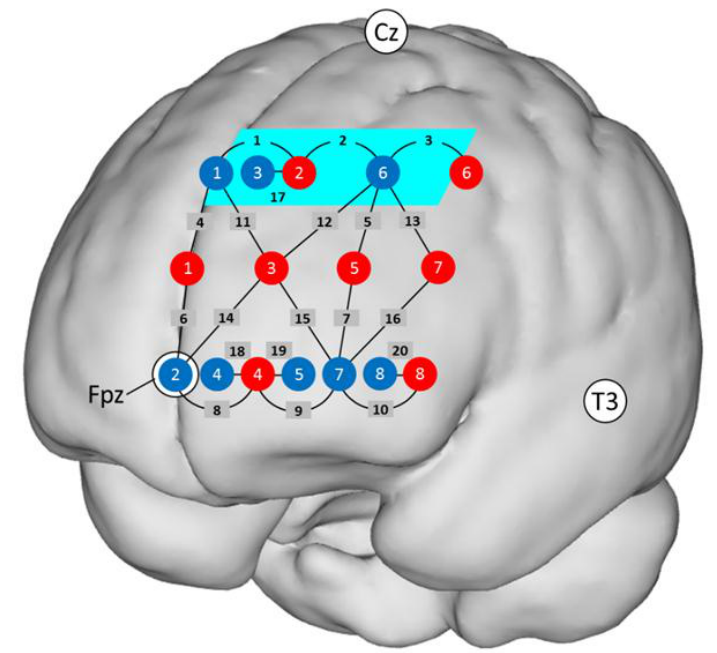
Figure 2. Localization of the 20 channels projected on a standard brain. There were eight detectors (blue dots) and eight emitters (red dots). The black numbers indicate channels. The area highlighted in turquoise (Channels 1, 2, and 3) corresponds to the region of interest (ROI). Channels 1–10 have a source–detector distance of ~30 mm; Channels 11–16, ~42 mm; Channels 17–20, ~15 mm. Detector 2 was placed at Fpz, Source 1 and Detector 1 on an imaginary line towards Cz, and the bottom row of fibers on an imaginary line towards T3.